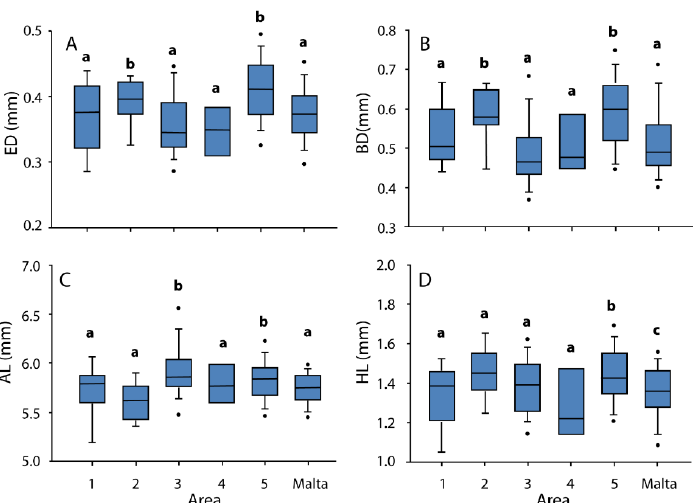
Figure 5. Box plots of the normalized morphometric parameters (eye diameter, ED ( A ); body diameter, BD ( B ); anal length, AL ( C ); head length, HL ( D )), by area. The bottom and top of the boxes are the first and third quartiles, while the whiskers indicate the 10 and 90 percentiles, and the band inside is the mean value. Black points indicate outliers. Lowercase letters (a–c) indicate statistically significant difference between the areas (pairwise tests, p -value <